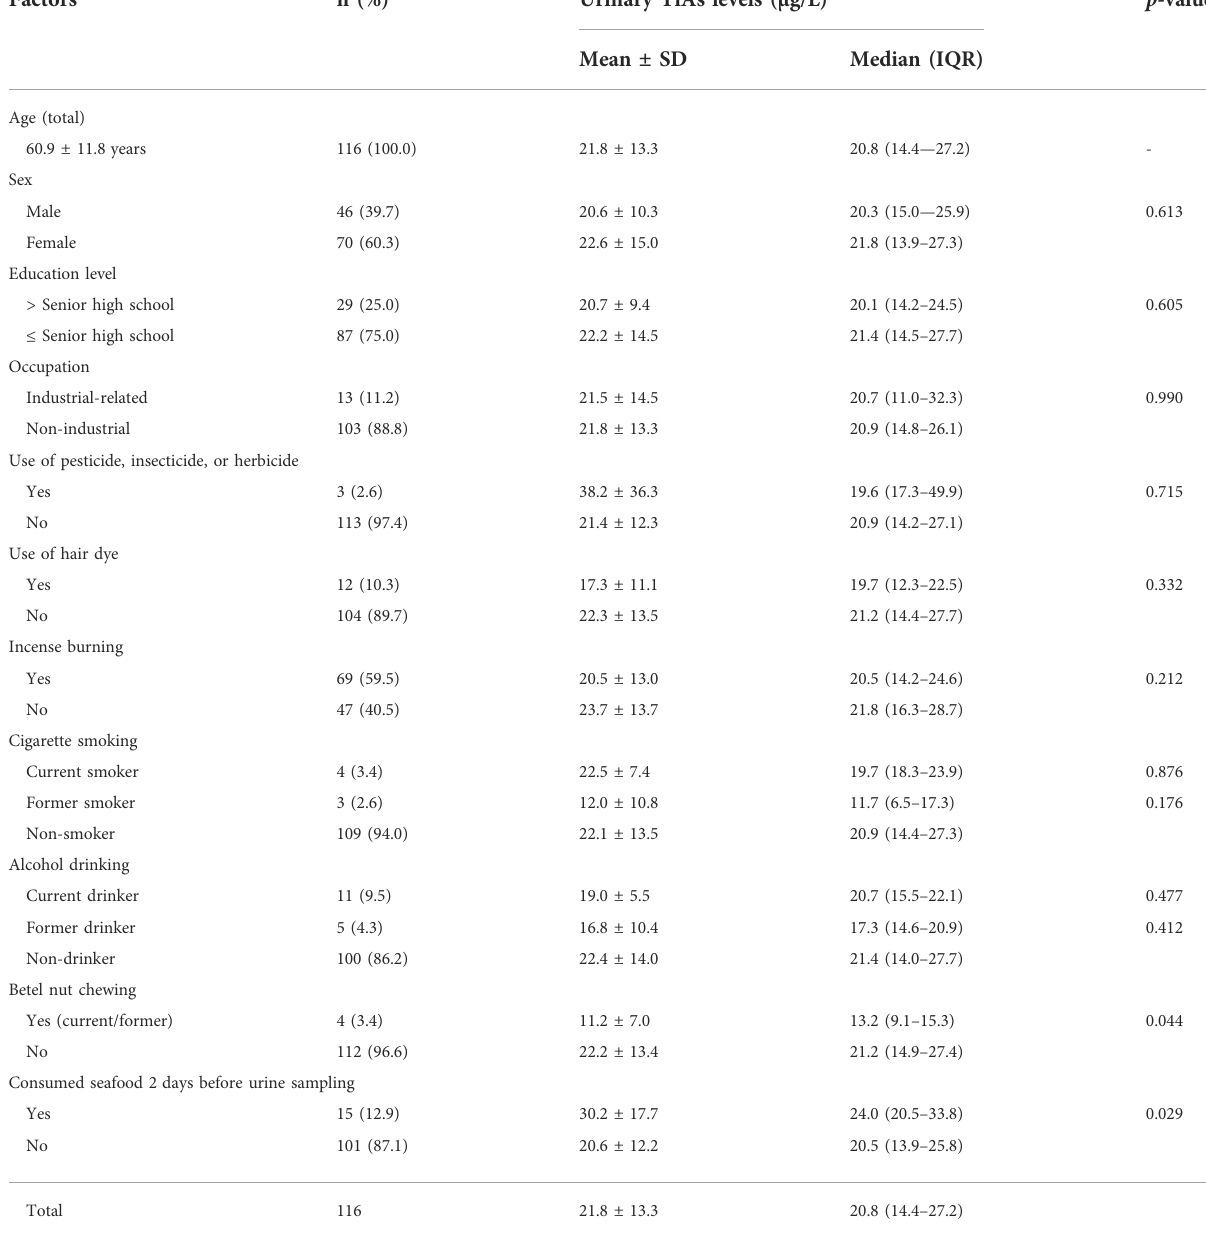
TABLE 2 Distribution of urinary total inorganic-related arsenic (TiAs) levels by different factors in 116 study subjects from six villages close to one coastal heavy-industrial area in Kaohsiung city in 2020 (Wave-3).